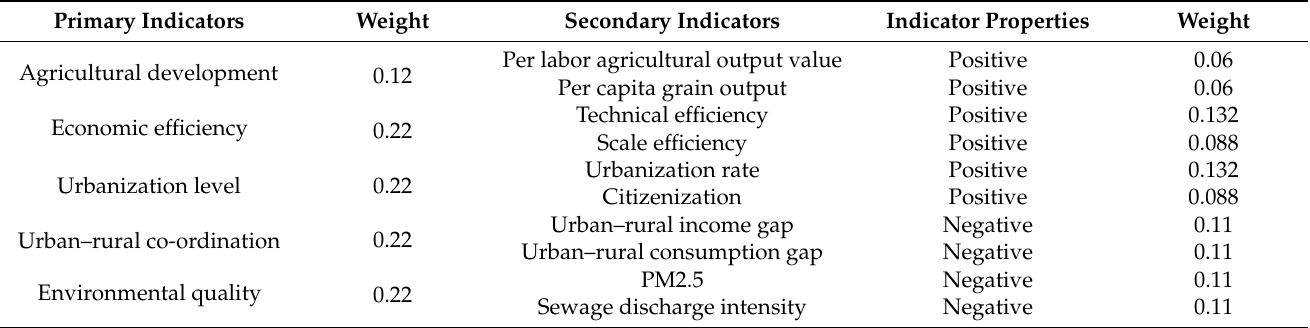
Table 3. Five-dimensional evaluation indicator system and the weights of urbanization